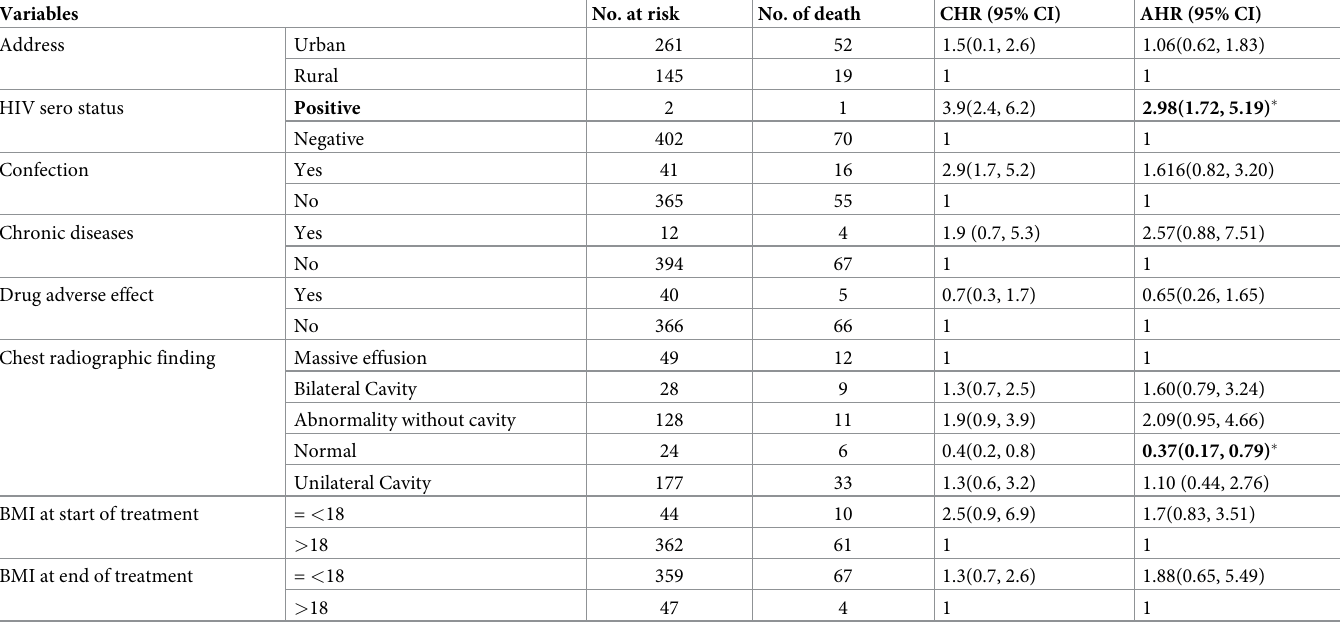
Table 3. Predictors of mortality among drug resistance tuberculosis infected patents in Oromia region, Ethiopia, 2020. Variables